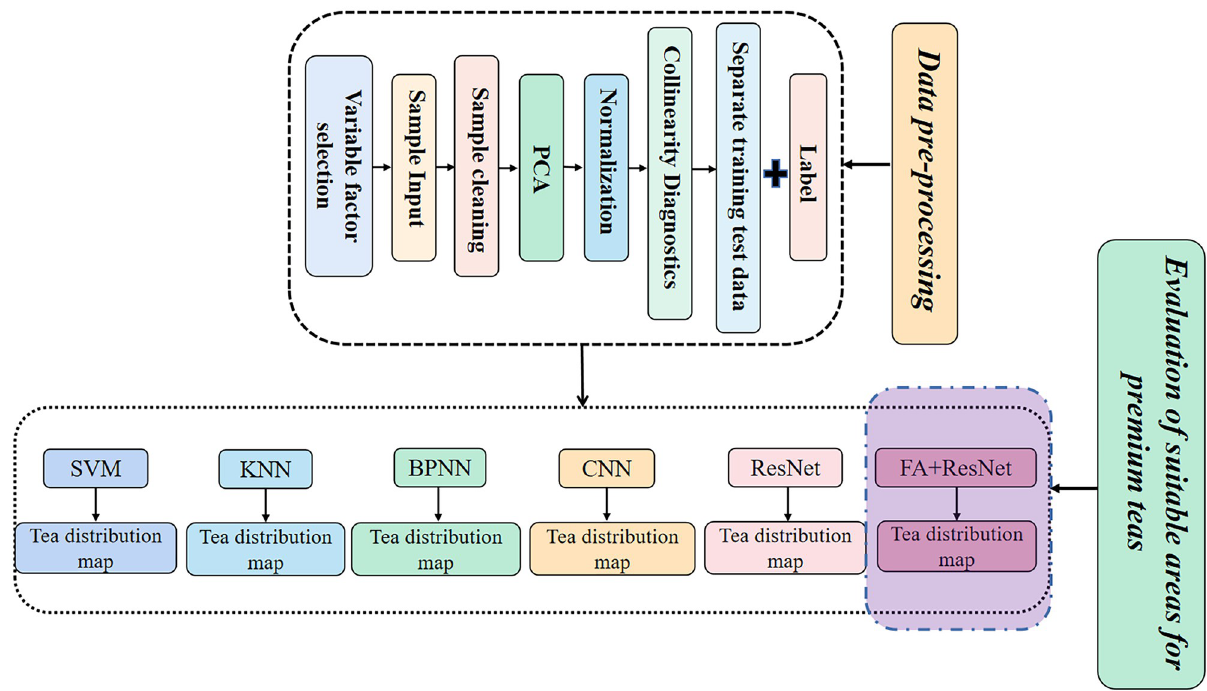
Fig 2. Data pre-processing and evaluation of premium tea suitable